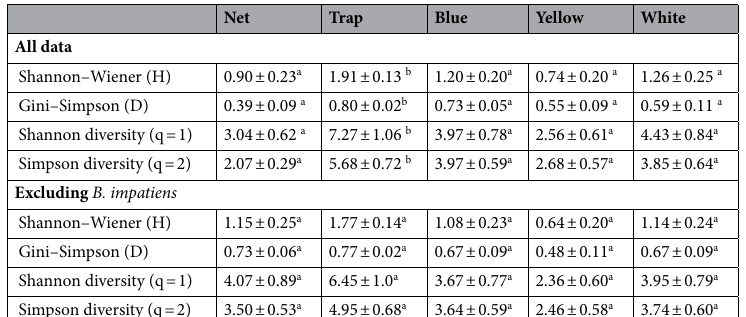
Table 3. Daily averages (Mean ± SEM) for diversity measures for the two survey methods (n = 20) and the three colors of pan traps (n = 30). The diversity measures are described in the text and were calculated using all data or excluding B. impatiens individuals. Different letters indicate statistical differences between treatments (survey methods or pan trap colors) based on analysis of variance with α = 0.05 and multiple means comparison test for color of pan traps. Statistical results are presented in the